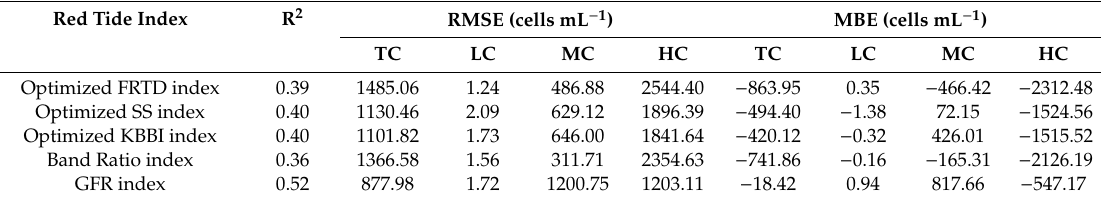
Table 5. Performance of red tide indexes applied to atmospherically corrected HSI R rs